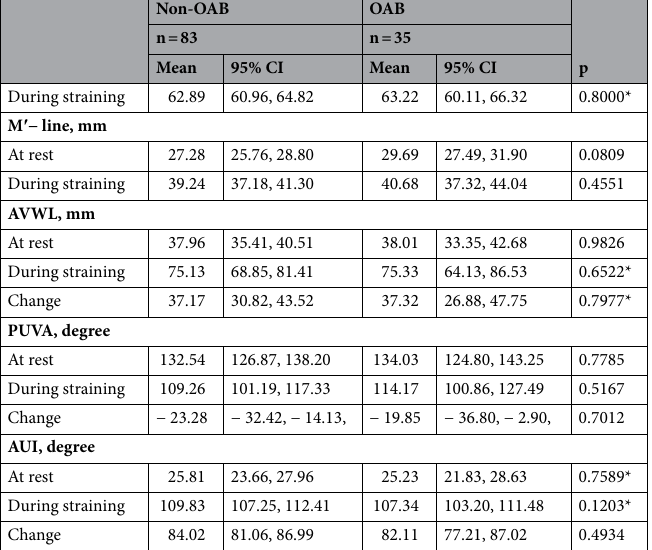
Table 2. Parameters on dynamic magnetic resonance imaging between patients with or without overactive bladder (OAB). x and y indicate the x and y coordinates of each pelvic organ point (AR, B, BN, and C). xx and yy indicate the distance between coordinate positions of the pelvic organ points before and during straining in x and y directions, respectively. p indicates the distance derived from the Pythagorean theorem. Note that the effect of pelvic organ mobility (POM) on the X-axis is negative when moving in the ventral direction and that of POM on the Y-axis is negative when moving in the caudal direction. Also, note that all diagonal POMs are positive. The p-value for numerical variables was calculated by Student’s t-test except the p-values with a superscript (*), for which the Wilcoxon rank sum test was used. AR, anorectal angle; AUI, angle of urethral inclination; AVWL, anterior vaginal wall length; B, most dependent position of the bladder; BN, bladder neck; C, uterine cervix; CI, confidence interval; H-line, length of the urogenital hiatus; iCL, imaginary line of the cardinal ligament; iUSL, imaginary line of the uterosacral ligament; M ′ -line, length of the hiatal descent; PUVA, posterior urethrovesical angle; ε,